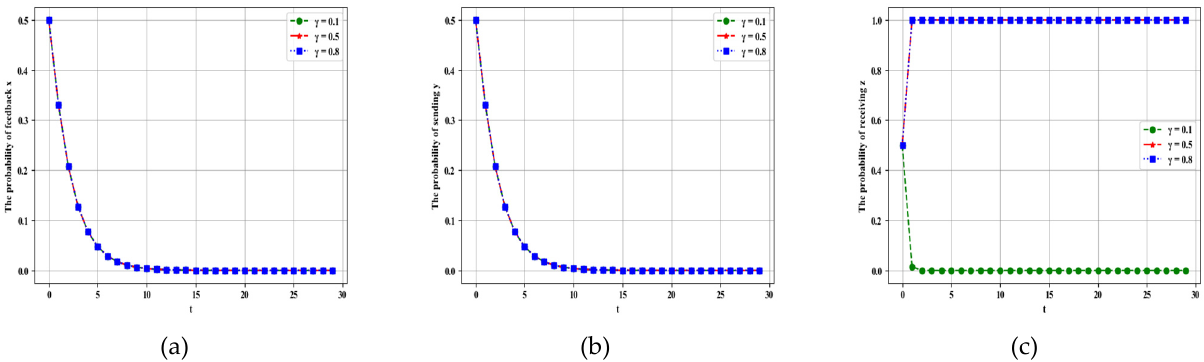
Figure 13. Evolutionary results of 𝛾 shown under different probabilities of strategies 𝑥, 𝑦,and 𝑧 in ( a ), ( b ), and ( c ), re-